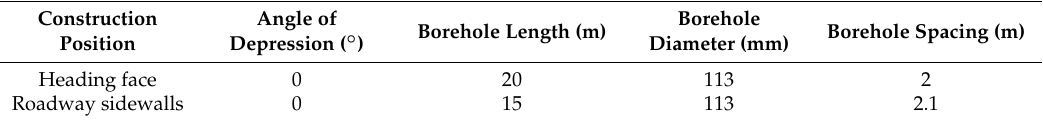
Table 7. Design parameters for large-diameter destress boreholes in the bottom slice of coal seam. Angle of Depression ( ◦